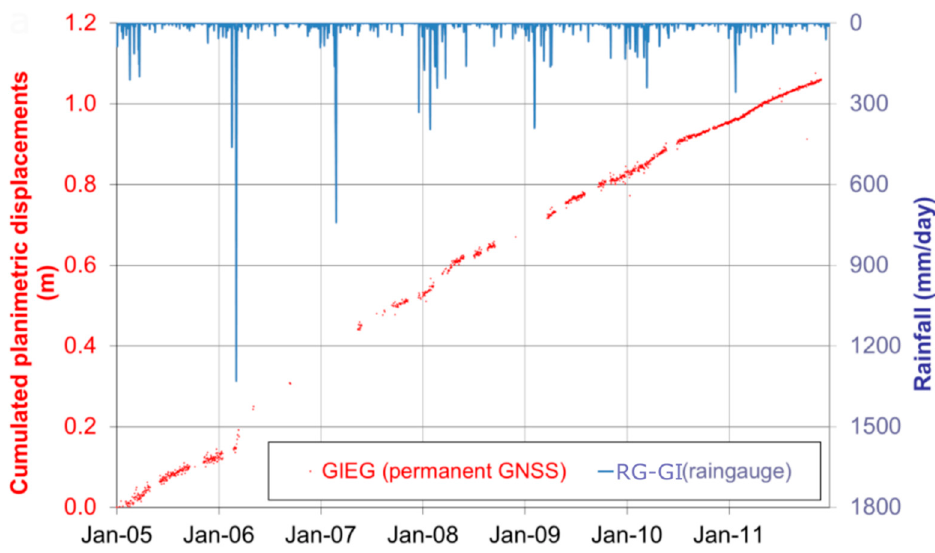
Figure 3. Daily rainfall (blue) at the Grand Ilet rain gauge RG-GI (Rain Gauge–Grand Ilet) and the cumulative displacement (red) at the GIEG permanent GNSS (Global Navigation Satellite System) from 2005 to 2011 [23]. See location of the rain gauge and GIEG station in Figure 4.